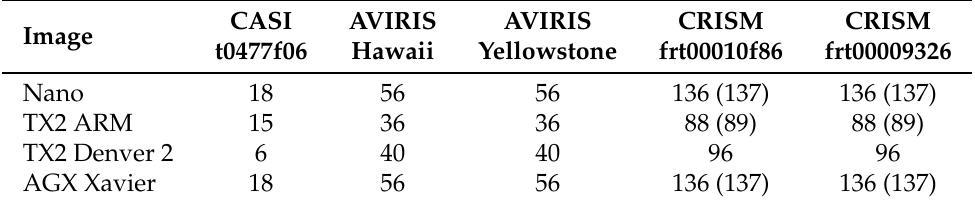
Figure 4. CCSDS-123 parallel sample adaptive entropy encoder execution times and speedups in multiple cores CPUs. The bars represent execution time of the worst-performing core of the bitstream generation and the bitstream concatenation time (please see Figure 2), while the lines represent speedup relative to serial execution time running in a single-core on the Nano system (For the CRISM images, the Nano executes half of the bands for the predictor and both encoders due to memory restrictions. The presented values are multiplied by two to simulate the full image workload). Table 3. Number of bands executed in each core during the bitstream generation on the parallel sample adaptive entropy encoder. CRISM images have an odd number of bands, thus one core executes the last